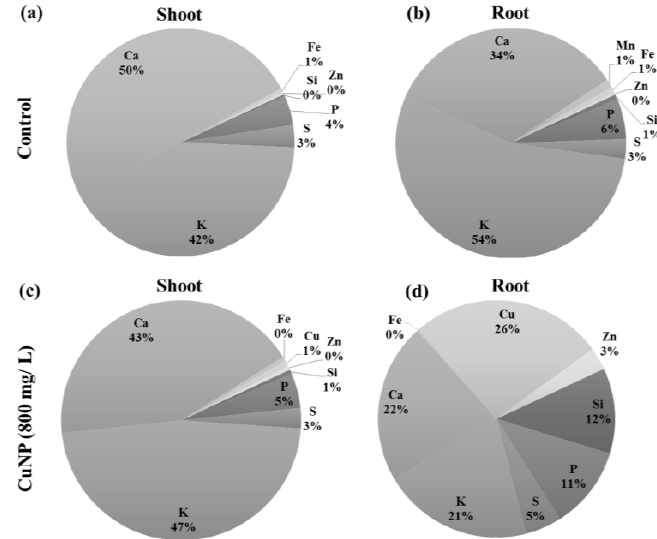
Figure 4. Elemental analysis of C. sativum plants after 7 days of exposure to 800 mg/L of CuNPs by XRF. ( a ) control shoot ( b ) control root ( c ) 800mg/L CuNPs treated shoot and ( d ) 800 mg/L CuNPs treated roots. Elemental profiles were obtained from three biological replicates.